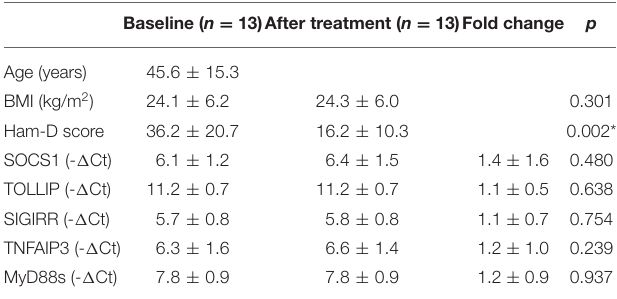
antidepressant treatment. Baseline ( n = 13)After treatment ( n = 13)Fold change p